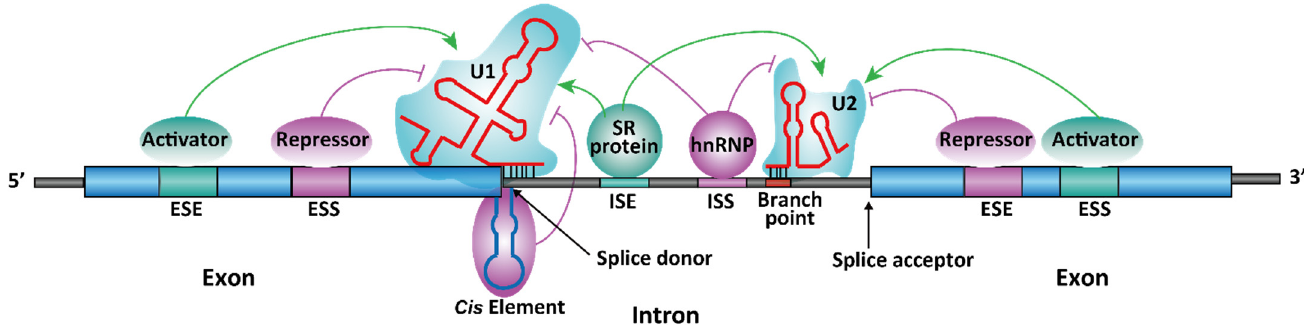
Figure 2. Regulatory mechanism for spliceosome-dependent splicing. ESE = exonic splicing enhancer, ESS = exonic splicing silencer, ISE = intronic splicing enhancer, ISS = intronic splicing silencer. A stem-loop structure at the 5 ′ splice was shown as an illustration of functional structural elements in regulating RNA splicing. The figure is modified from ViralZone, SIB Swiss Institute of Bioinformatics.